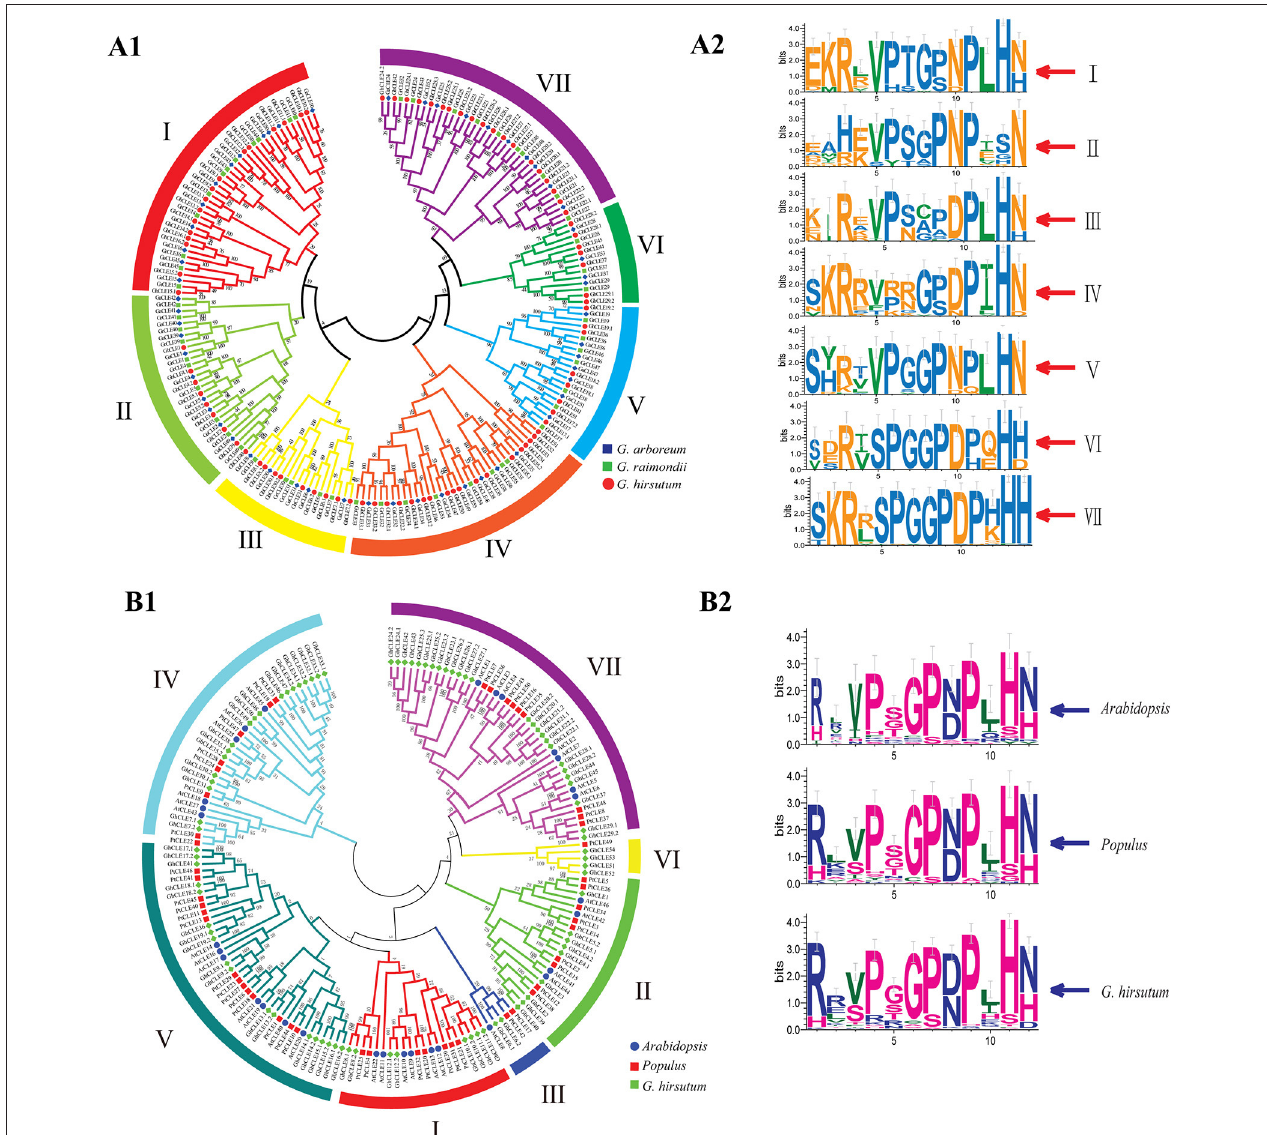
FIGURE 1 | Phylogenetic trees were established using MEGA7 with the neighbor-joining (NJ) method. (A1) Phylogenetic tree of CLEs among G. raimondii , G. arboreum , and G. hirsutum . (A2) The weblogo represents CLE motifs (14 amino acids) of seven groups. (B1) Phylogenetic tree of CLEs among G. hirsutum , Arabidopsis, and Populus . (B2) The weblogo represents CLE motifs of Arabidopsis , poplar, and G.hirsutum (12 conserved amino